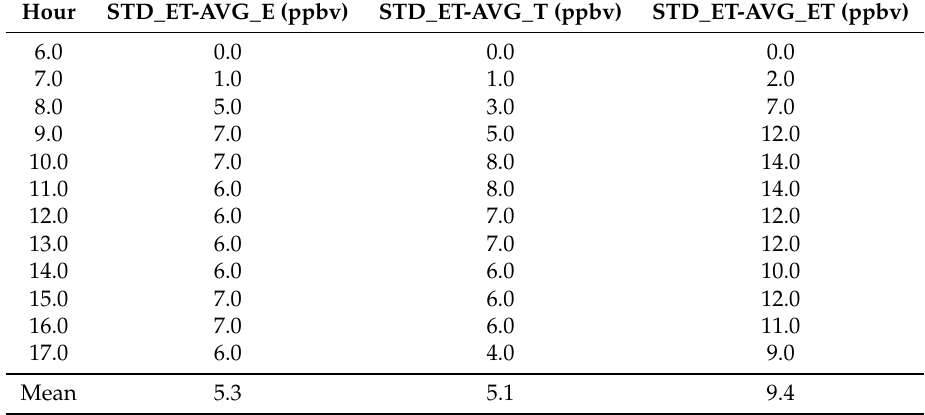
Table 4. Table showing differences in ozone (ppbv) for 18 January between 6:00 a.m. and 5:00 p.m. for various scenarios where STD_ET is the run under standard or normal biogenic emissions and temperatures, AVG_E is the run with averaged biogenic emissions, AVG_T is the run with averaged temperatures and AVG_ET is the run with both averaged biogenic emissions and temperatures.